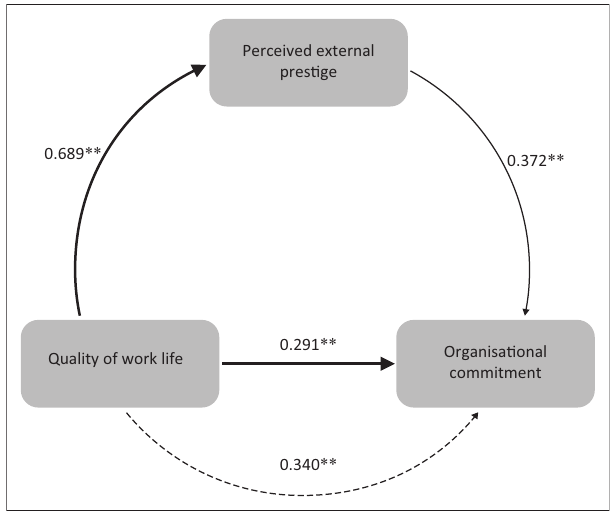
FIGURE 1: Mediating model showing the relationship between quality of work life and organisational commitment, as mediated by perceived external prestige. Along the lower path, the dashed line indicates the indirect effect of quality of work life when perceived external prestige is included in the model. Asterisks indicate significant path coefficients ( ** p <